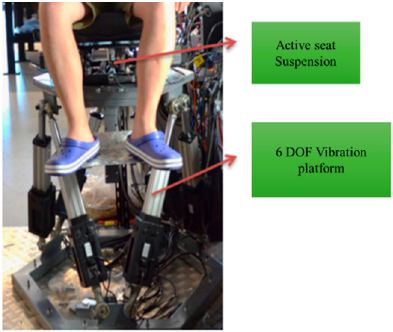
Figure 20. Experimental setup of active seating suspension system with a sliding mode controller [22].